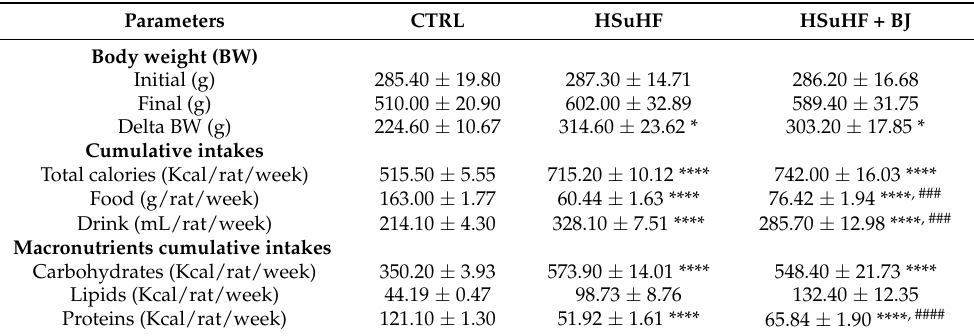
Table 2. Body weight, cumulative total calories, food, drink, and nutrient intakes of the animals after 23 weeks of the experimental